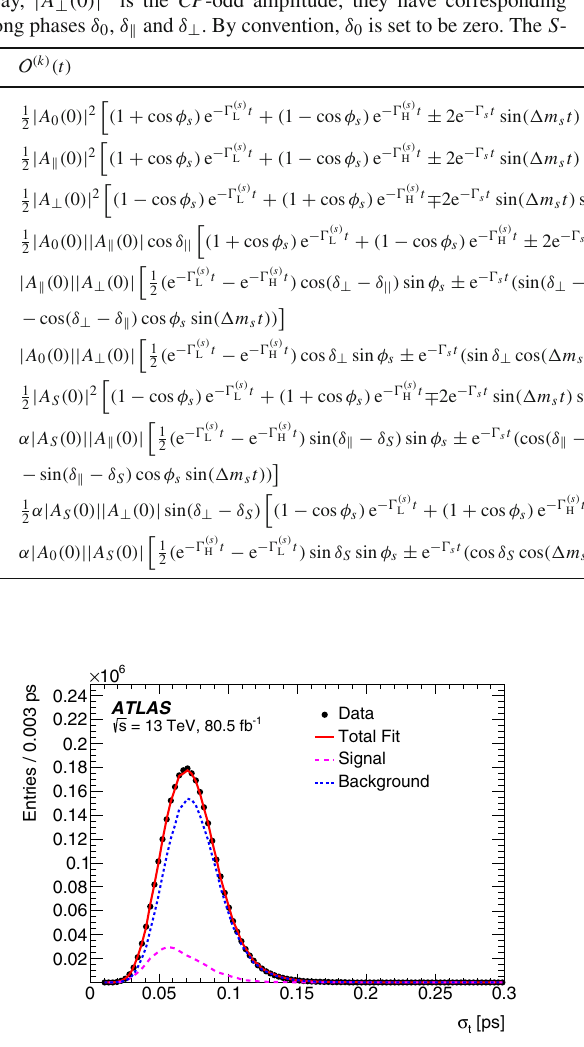
The same approach was applied for the probability terms | p ) and P ( p ) accounting for differences between P s (σ m T i s T i i signal and background events for the values of the per- values, respectively. The tag- candidate mass error and p T i ging probability term for signal P s ( P i ( B | Q x )) is described in Sect.